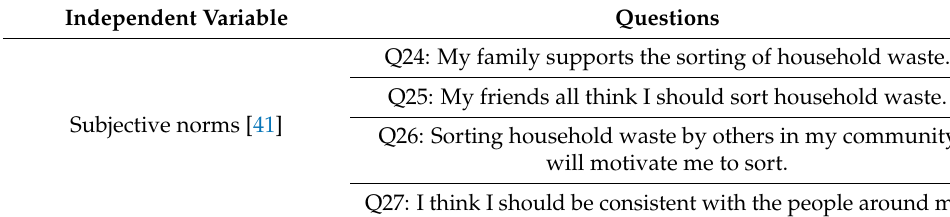
Table 6. Subjective norm questions.